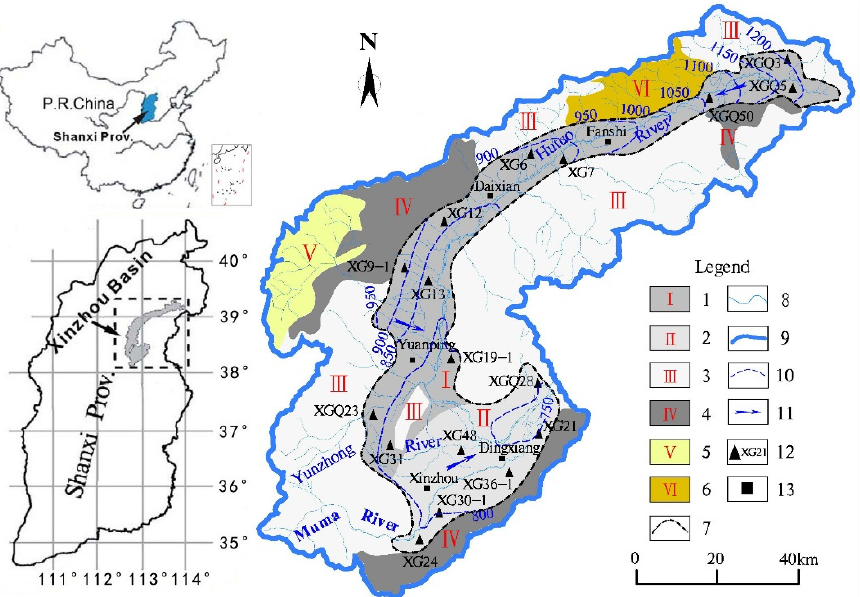
Figure 1. Hydrogeological map and monitoring well locations of the study area. 1. Quaternary alluvial proluvial sediment; 2. Quaternary alluvial lacustrine sediment; 3. Magmatic and metamor- phic rock; 4. Limestone; 5. Detrital rock; 6. Basalt; 7. Basin boundary; 8. River; 9. Basin watershed; 10. Contours of groundwater level; 11. Groundwater flow direction; 12. Monitoring well locations; 13. County.